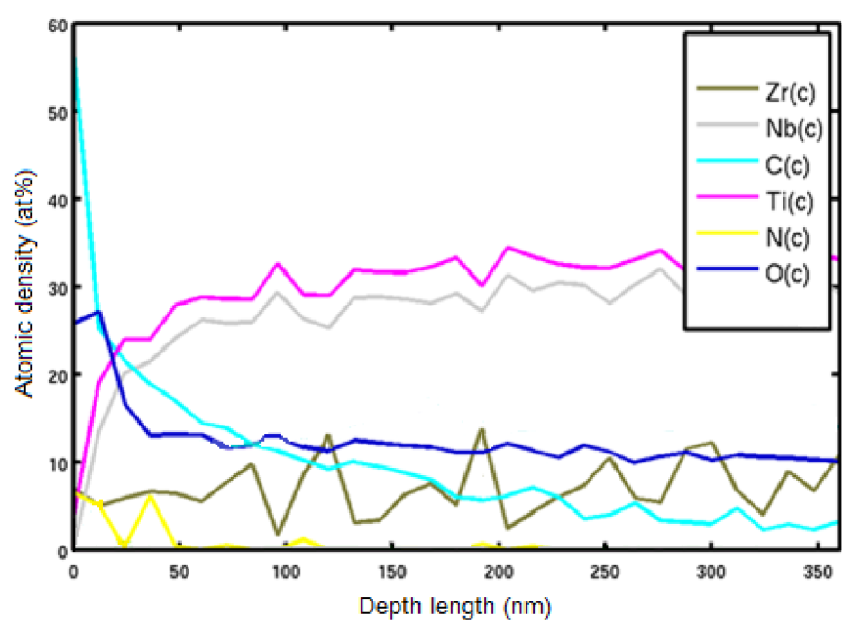
Figure 11. The surface composition of the polished wire of Ti–28Nb–5Zr alloy.